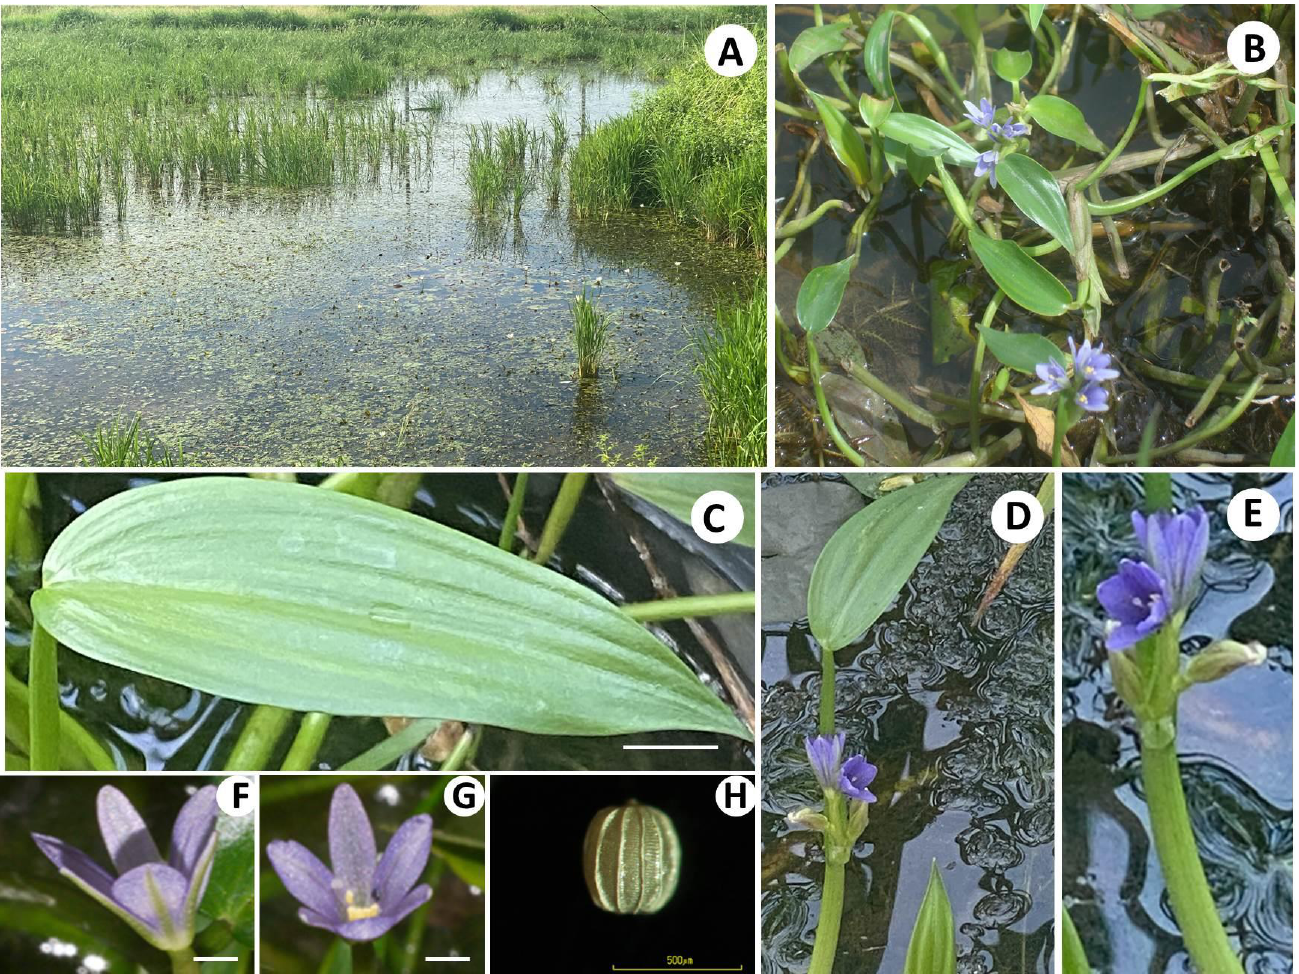
Figure 1. M. angustifolia ( A ): Natural Habitat, ( B ): The whole plant with inflorescence, ( C ): Leaf, Bar scale = 0.5 cm; ( D , E ): Inflorescence, ( F ): Flower (side view) Bar scale = 0.3 cm; ( G ): Flower (top view) Bar scale = 0.3 cm; ( H ): Seed, Bar scale = 500 µm. All photos were taken in Thailand by D.T.